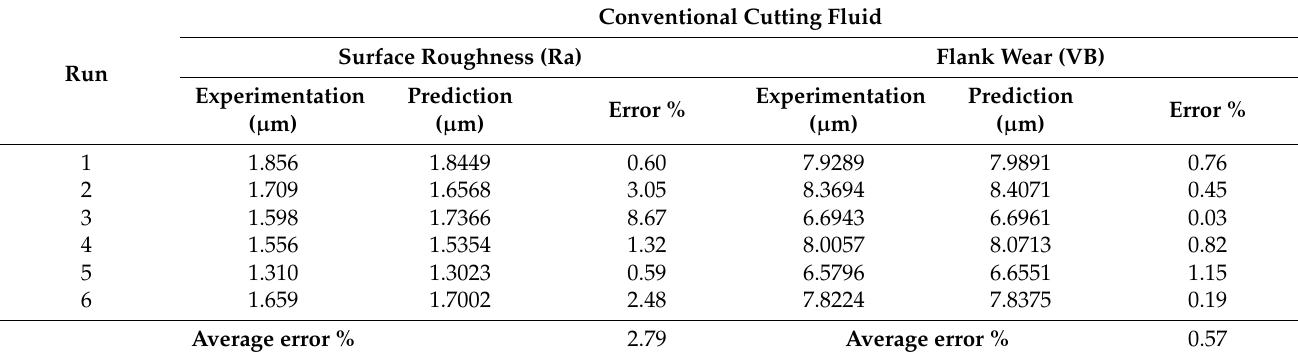
Table 14. Comparison of ELM prediction with experimental findings for conventional cutting